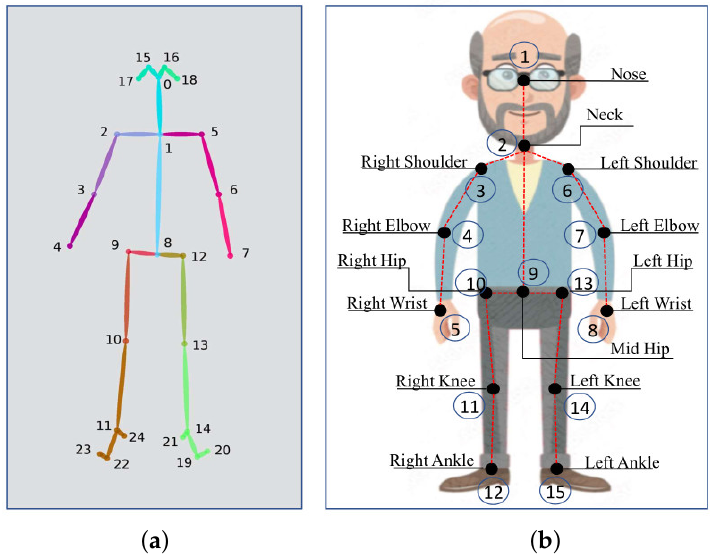
Figure 5. ( a ) Skeleton joints extracted by using Body_25 model in OpenPose. ( b ) Skeleton joints used in this